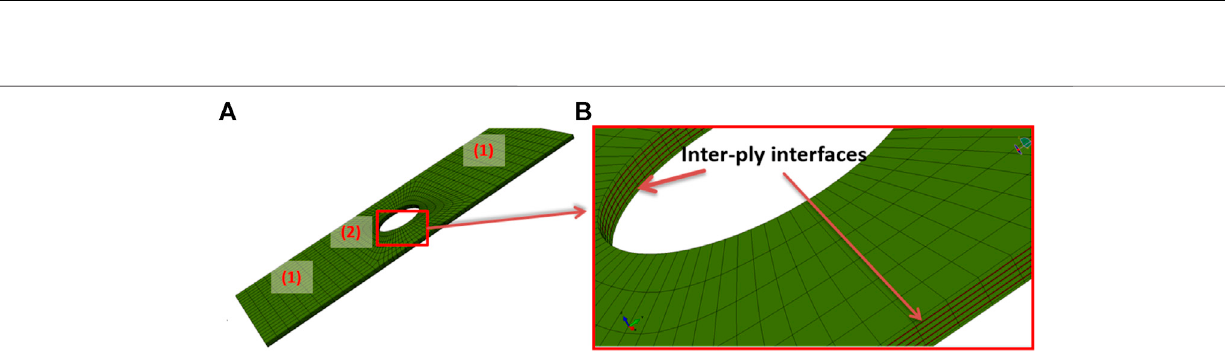
FIGURE4| “ Meshsuperpositiontechnique ” appliedtotheTFPpatch: (A) circularpatchand (B) ellipticalpatch.Theyarnmeshisembeddedintothematrixmeshto avoid the meshing dif fi culties at the places where the inter-yarn space is extremely tiny.